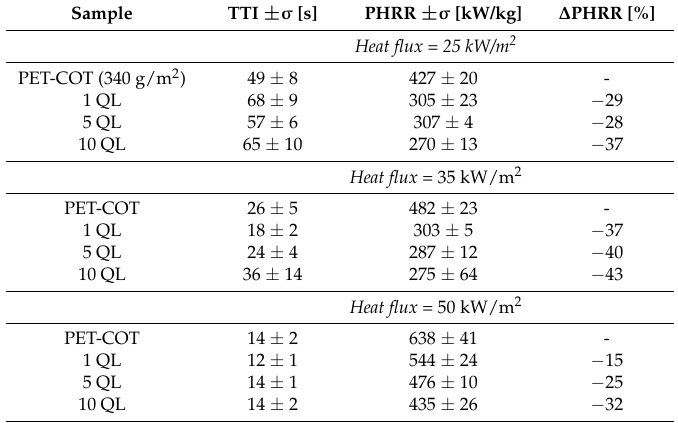
Table 13. Combustion data of untreated and QL-treated PET-COT by cone calorimetry at different heat fluxes